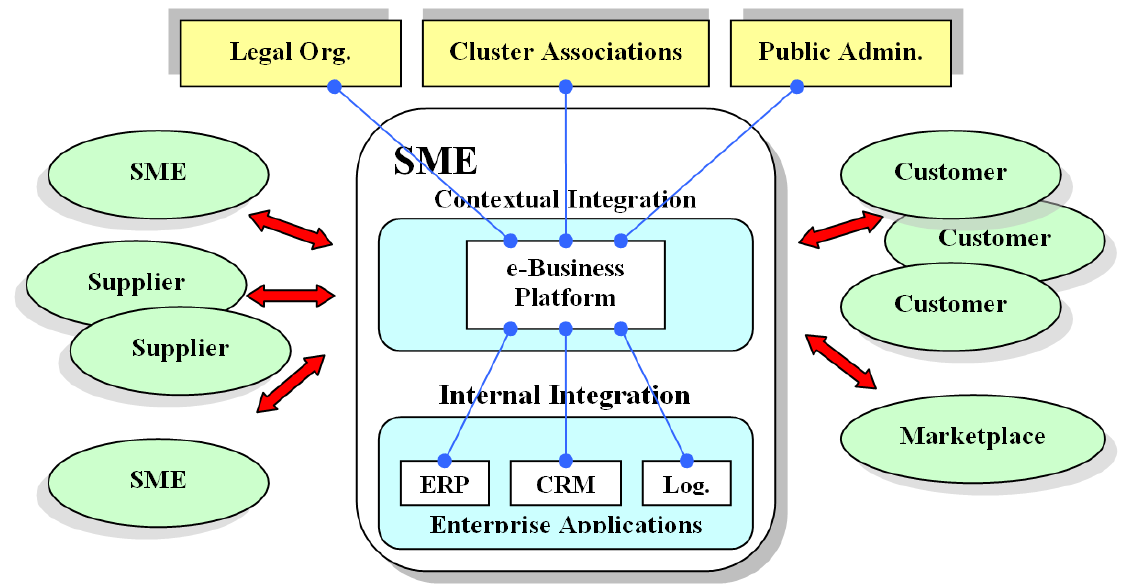
Fig. 1. e-NVISION e-Business